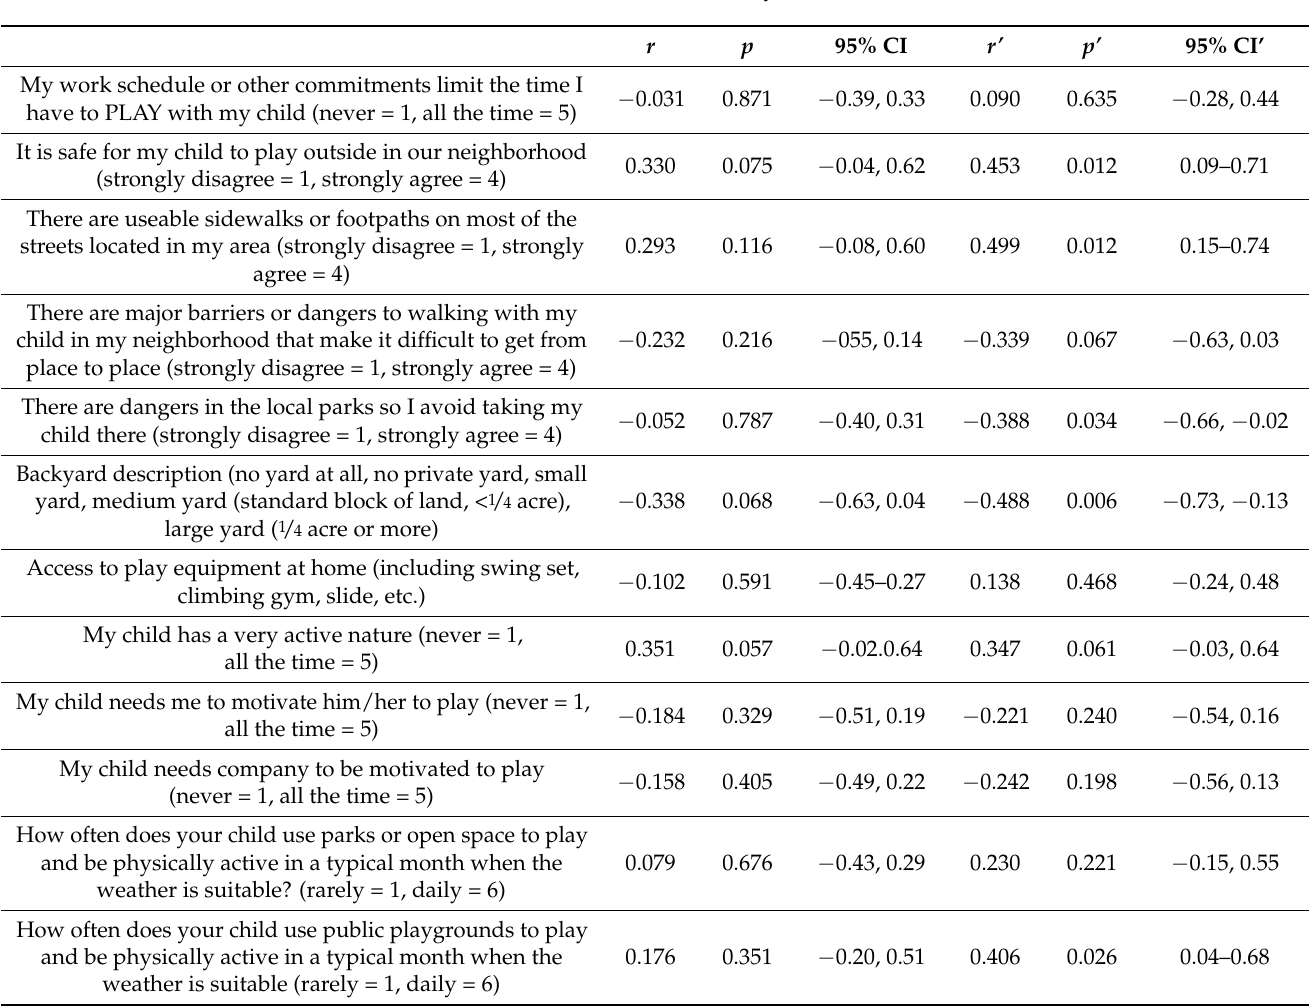
Table 5. Spearman correlations between child, neighborhood, and home characteristics with total child MVPA ( r ) and child MVPA on weekday afternoons ( r’